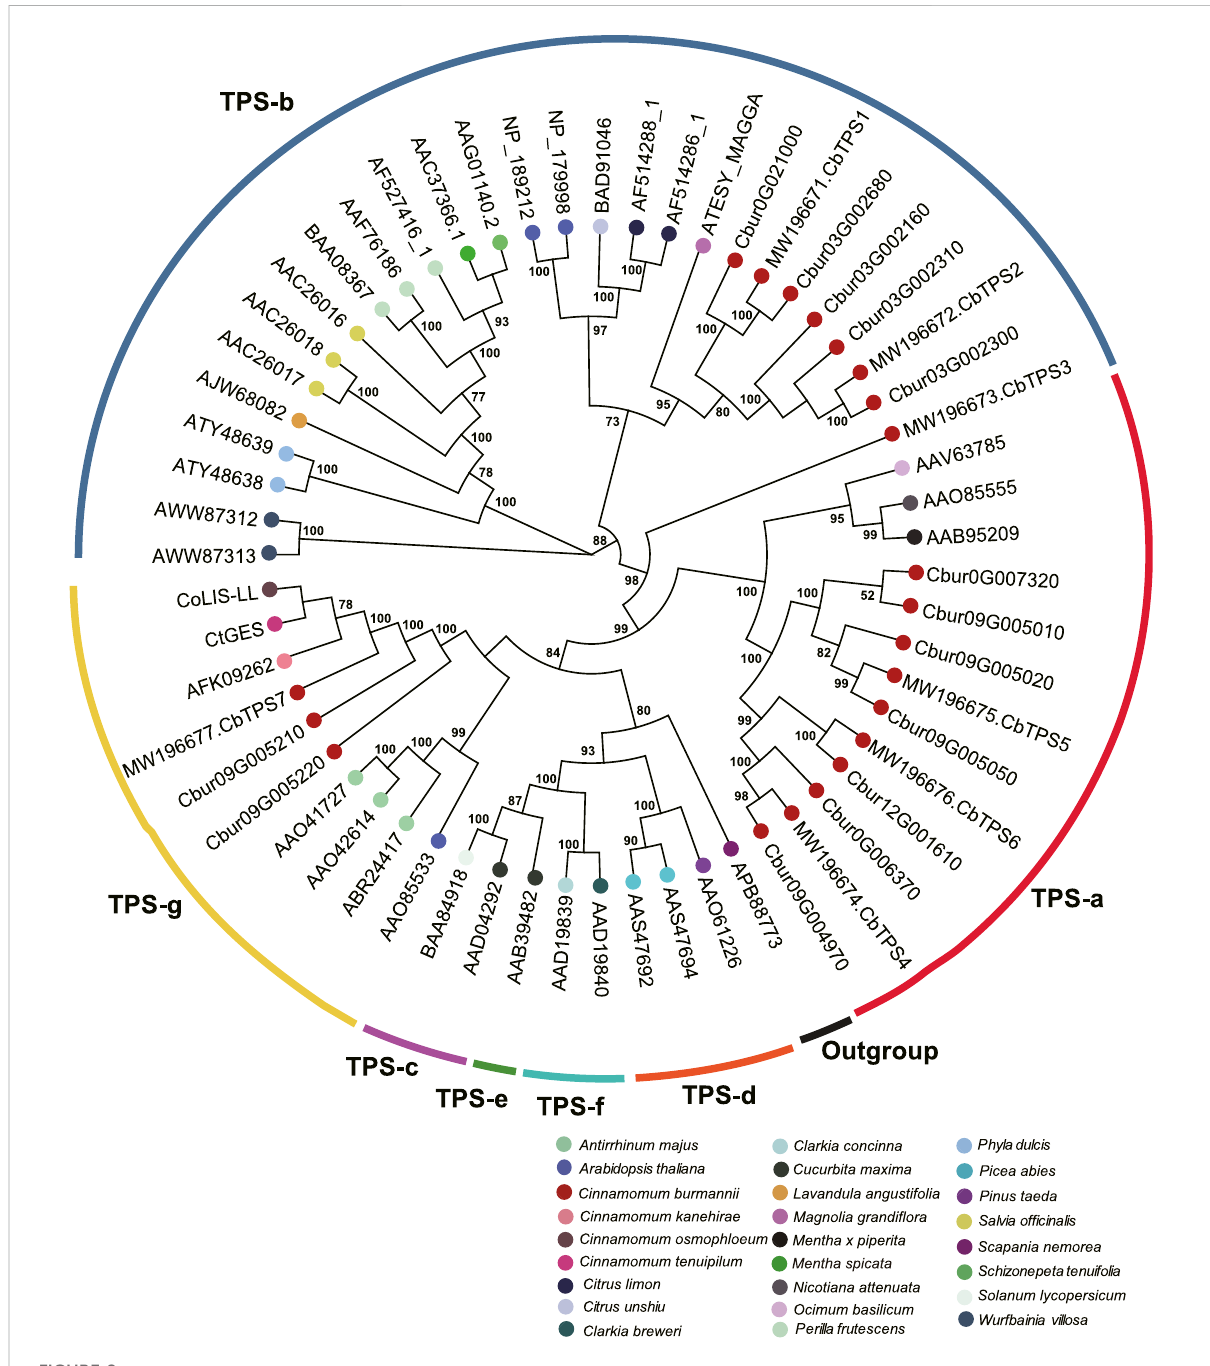
FIGURE 8 Phylogenetic relationship among the TPS genes of Cinnamomum burmannii established by the maximum likelihood method. Bootstrap values ≥ 50are given atthenodes.The TPS genes of C.burmannii identi fi edinthepresentstudy and otherrereprentative TPS genes areindicated by the dots in different color. The accession information used for phylogenetic reconstruction is